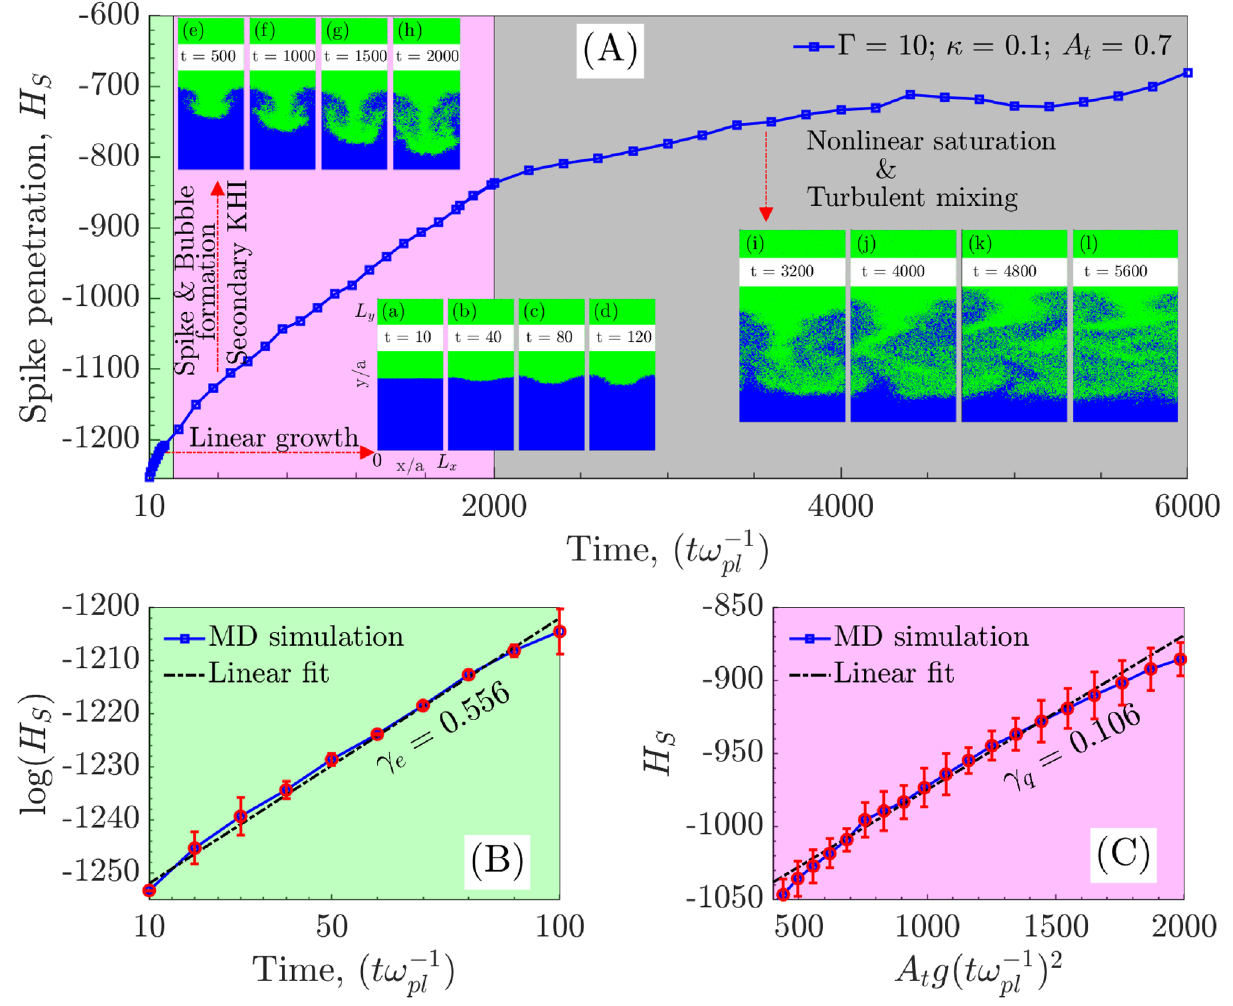
Figure 3. ( A ) Spike amplitude in single-mode RTI covering exponential and quadratic growth regimes and the nonlinear saturation stage. In subplot ( A ), the insets ( a – d ) show linear growth of modes, insets ( e – h ) shows the formation of spikes of heavy fluid and bubbles of light fluid and insets ( i – l ) show the nonlinear saturation that finally leads towards the turbulent mixing. ( B ) The exponential growth regime at the early-evolution stage, and ( C ) the quadratic growth regime during later evolution. The error bars in subplots ( B , C ) reflect the statistical error associated with the mean spike amplitude. An error has been calculated as the statistical variation in spike amplitude from its mean value for multiple simulation replicas for the same